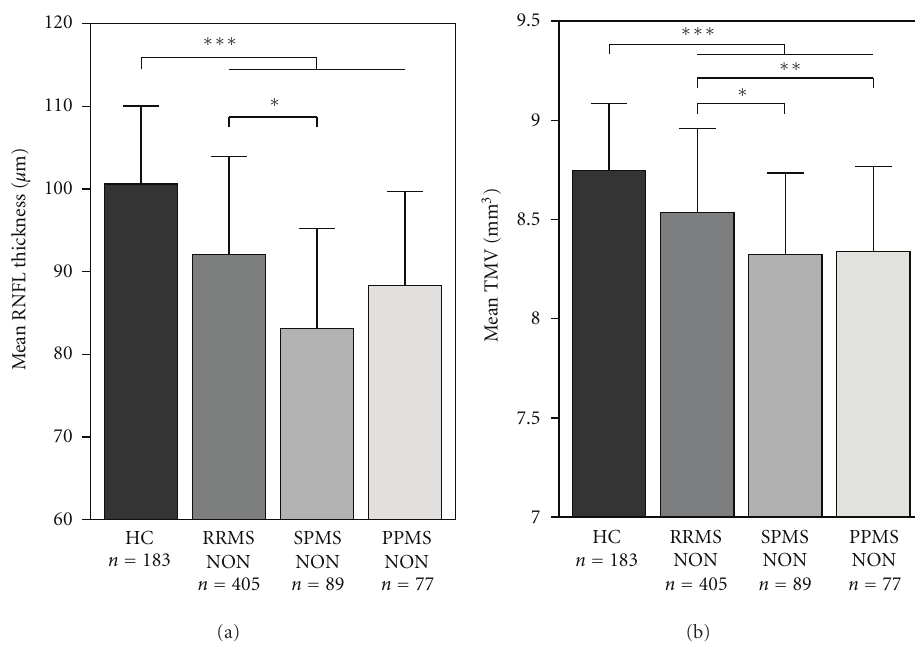
Figure 1: Mean retinal nerve fibre layer (RNFL) thickness (a) and mean total macular volume (TMV) (b) for the healthy controls (HC) and MS subtypes (RRMS, SPMS, and PPMS) without a history of optic neuritis (NON). Significant di ff erences between the groups are indicated with ∗ ( P < 0 . 05), ∗∗ ( P < 0 . 01), and ∗∗∗ ( P < 0 . 001), respectively.